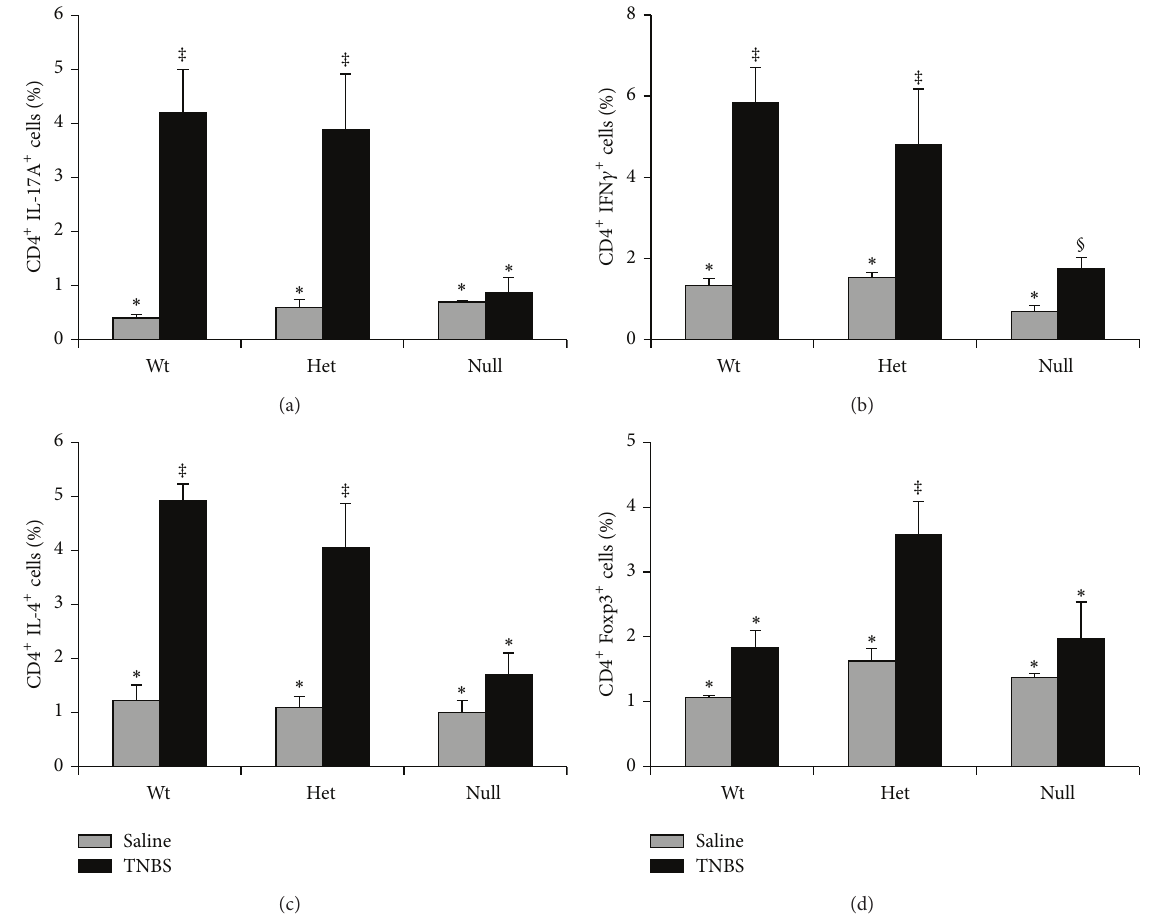
Figure 6: Percentage of splenic CD4 + T cell subsets in Wt, Het, and Null Fads1 TNBS-treated mice (black bars, 𝑛 = 6 –9 mice/genotype) and saline controls (grey bars, 𝑛 = 3 -4 mice/genotype). (a) Th17 cells (CD4 + IL-17A + ), (b) Th1 cells (CD4 + IFN 𝛾 + ), (c) Th2 cells (CD4 + IL-4 + ), and (d) Tregs (CD4 + Foxp3 + ). Data were analyzed by two-way ANOVA (main effects: genotype and treatment). Bars represent means ± SEM. Bars not sharing a symbol differ ( 𝑃 ≤ 0.05